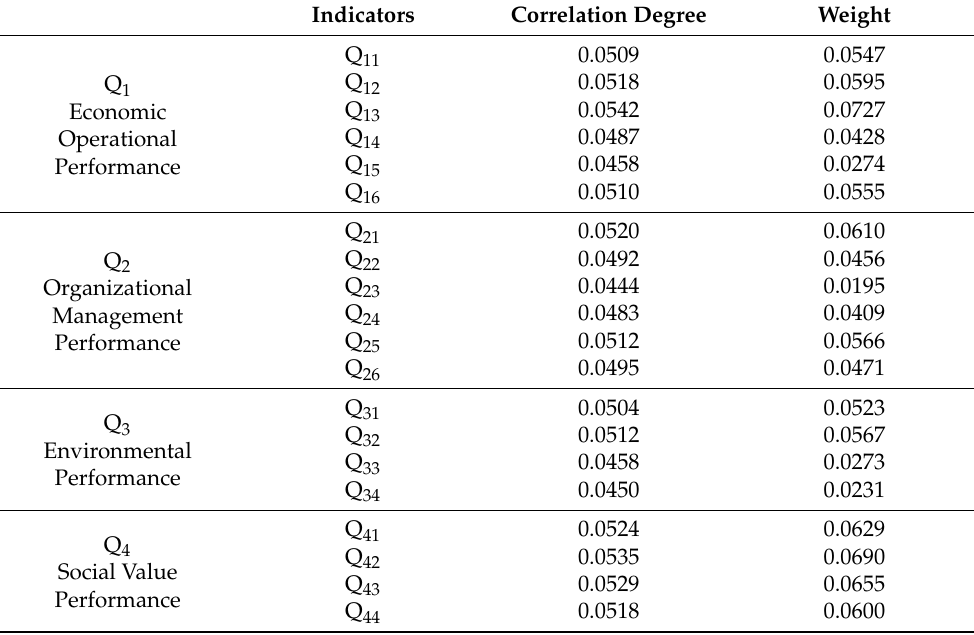
Table 3. Correlation degree and weight result of self-encoder index.